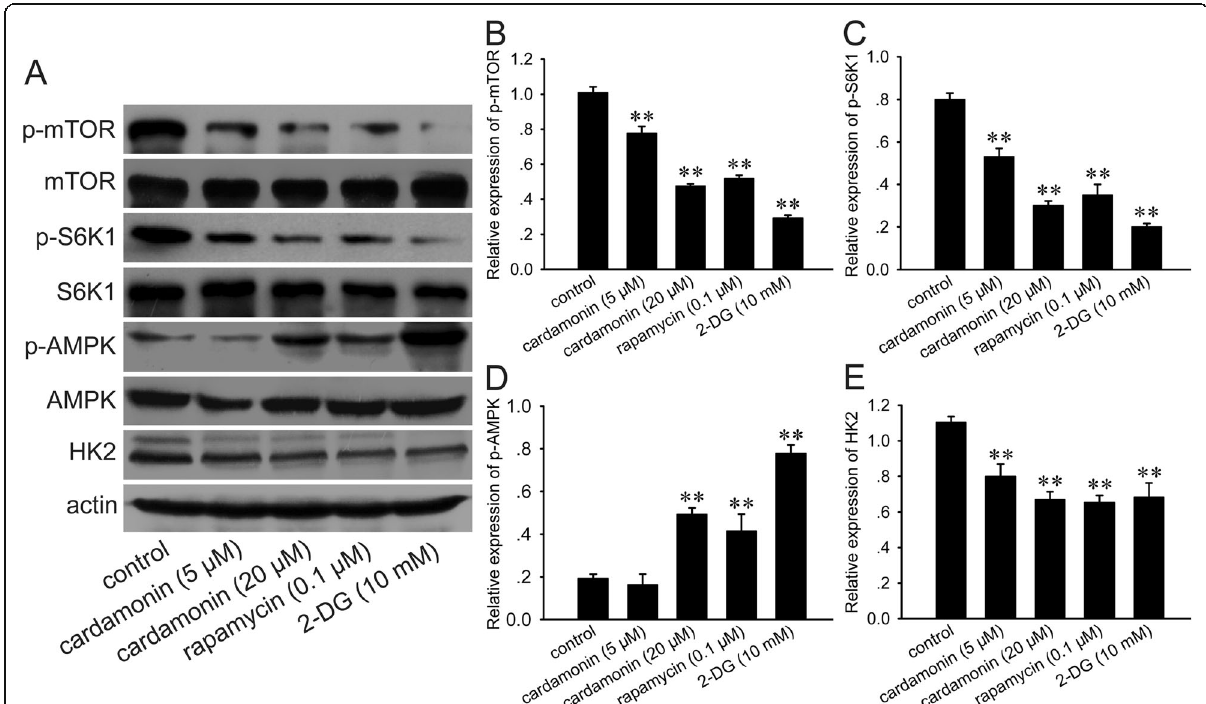
Fig. 3 Expression and phosphorylation of S6K1, mTOR, AMPK and HK2. SKOV3 cells were treated with cardamonin (5, 20 μ M), rapamycin (0.1 μ M) and 2-DG (10 mM) for 48 h, respectively. a Expression of protein was detected by Western blot. b - e Quantification of protein by densitometry of Western blot performed above. * p < 0.05, ** p < 0.01 vs. control. Data were represented as mean ± SD, n =